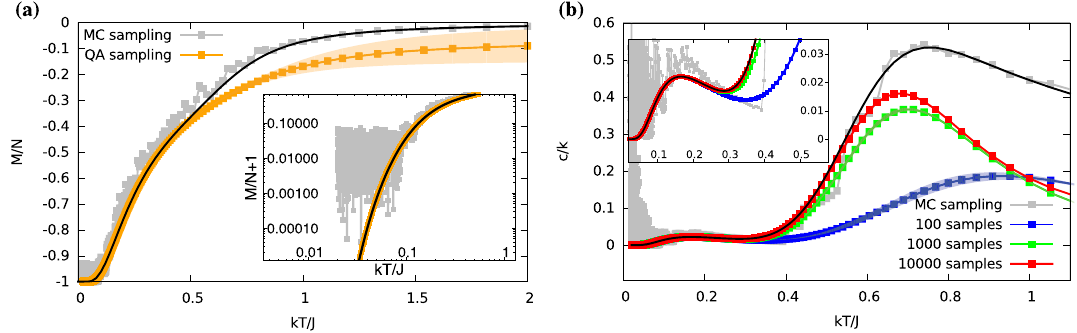
Figure 4. Comparison to Metropolis Monte Carlo sampling. ( a ) Comparison of the analytical theory, Metropolis Monte Carlo sampling and quantum annealing sampling for the 1D Ising model with N = 20 spins and B / J = 0.01 . Whereas the Metropolis algorithm performs well in the high temperature regime, the results get noisy for low temperatures due to the high rejection rate of proposed states. Notice that the used 10 trial configurations correspond to more than the 2 N configurations of the phase space, while only 100 samples with 10 spin flip transformations are necessary for the quantum annealing sampling. The exact analytical solution is depicted as black solid line. The inset shows the magnification of the low temperature regime using a logarithmic representation of M / N + 1 . ( b ) Heat capacity per spin for the same parameter set as in panel ( a ). The plot compares the analytical solution (black curve) to the Metropolis MC sampling (grey curve) and QA predictions for different number of reads. The inset shows the magnification of the low temperature